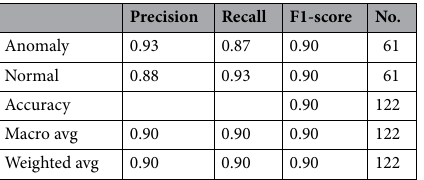
Precision Recall F1-score No.